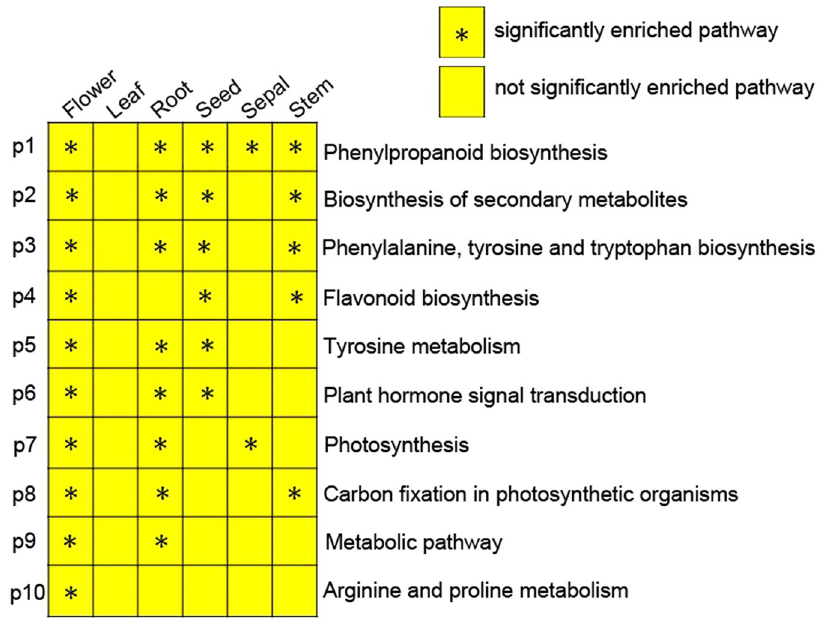
Figure 4. Venn diagram that describes unigenes overlaps among organs of D. tanguticum